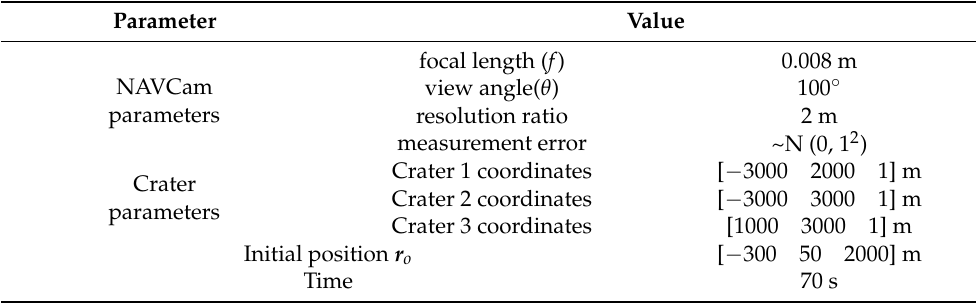
Table 1. Simulation condition of Torus-OPNAV algorithm feasibility